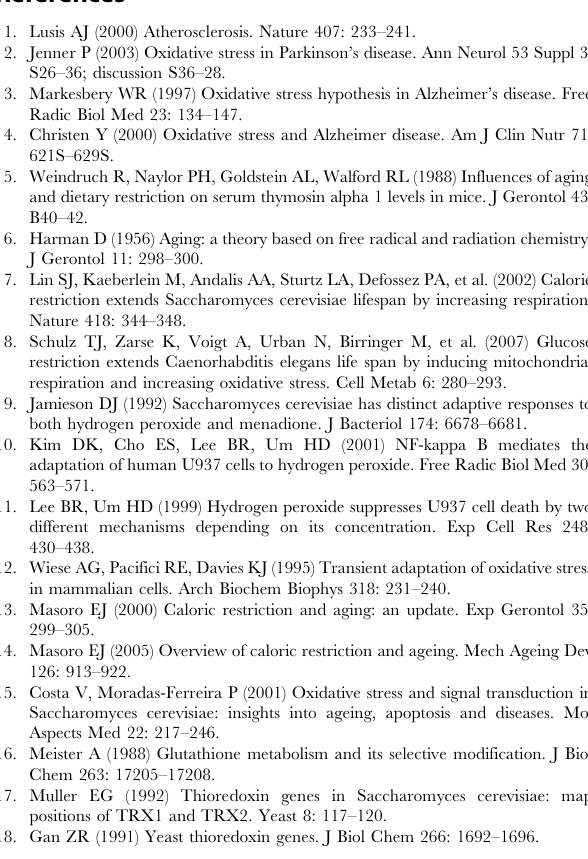
Table S1 Sensitive gene ontology categories following acute hydrogen peroxide stress. For our study and the study of Thorpe et al. , we determined those gene ontology categories which were enriched for sensitive gene deletions. Here we report all categories which exceed the threshold for significance. Table S2 Up-regulated transcription factor target sets following acute hydrogen peroxide stress. For our and previous comparable studies (Gasch 2000, Causton 2001, Shapira 2004), the set of known targets for each transcription factor was ranked based on enrichment for genes with increased expression in response to acute hydrogen peroxide stress. Here, we report the top nine sets of transcription factor targets. To facilitate comparison, frequently occurring items are high-lighted in a consistent manner. Table S3 Up- and down-regulated gene ontology categories following acute hydrogen peroxide stress. For our and previous comparable studies (Gasch 2000, Causton 2001, Shapira 2004), a pruned set of functional categories was ranked based on enrichment for genes with increased and decreased expression in response to acute hydrogen peroxide stress. In each case, we report the top five categories. To facilitate comparison, frequently occurring categories are high-lighted in a consistent manner. Table S4 Primer sequences for RT-PCR profiling of gene expression.